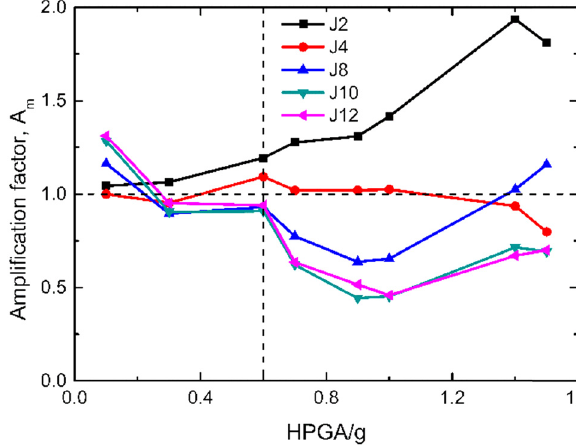
Figure 18: Ampli fi cation factor A m at J2, J4, J8, J10, and J12 vs vari - able